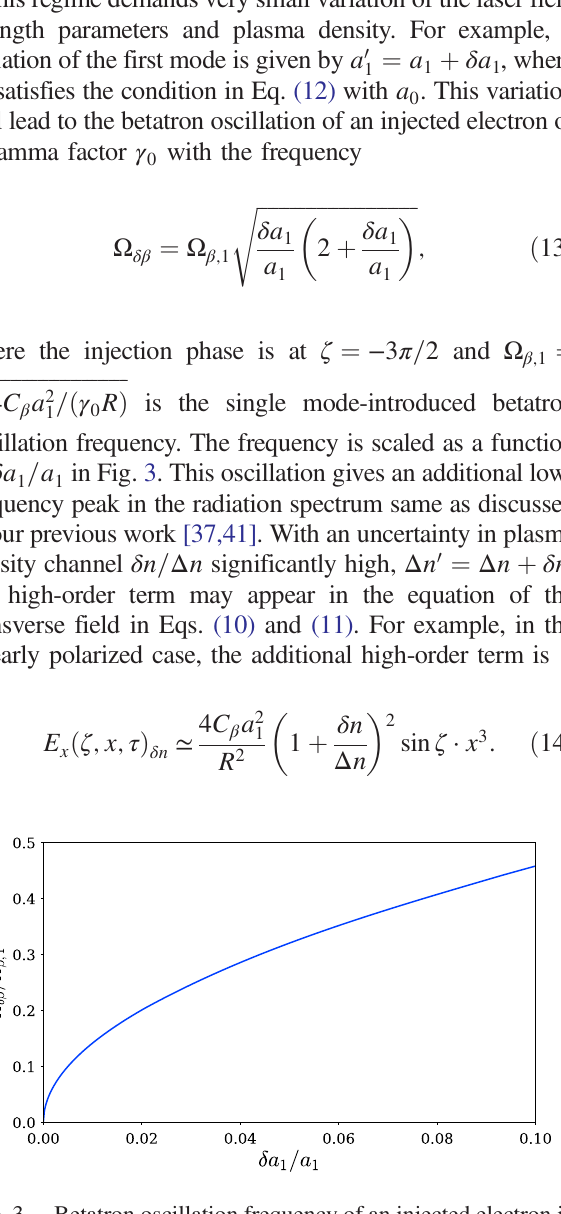
FIG. 3. Betatron oscillation frequency of an injected electron in Eq. (13), introduced by the inaccuracy of laser strength, a 1